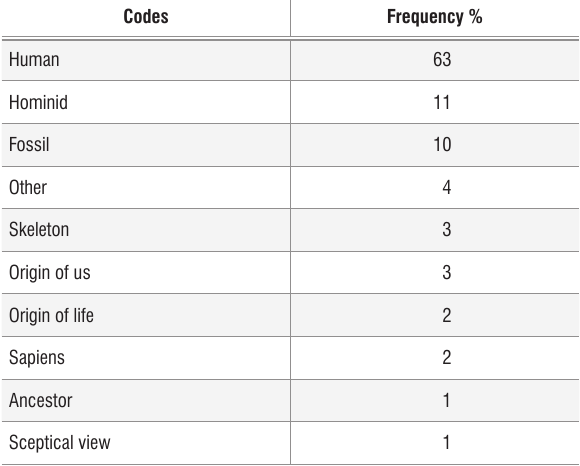
Frequency of codes for participants explaining the name